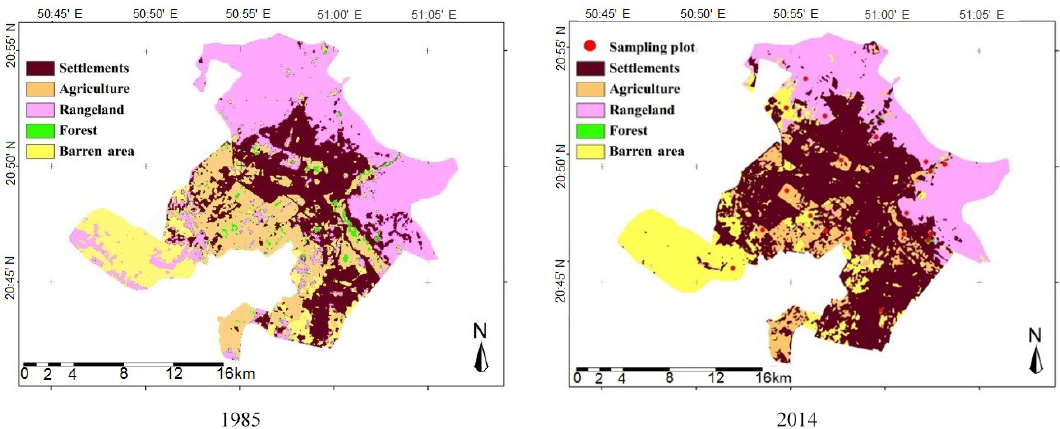
Figure 2. Land use/cover classes in 1985 and